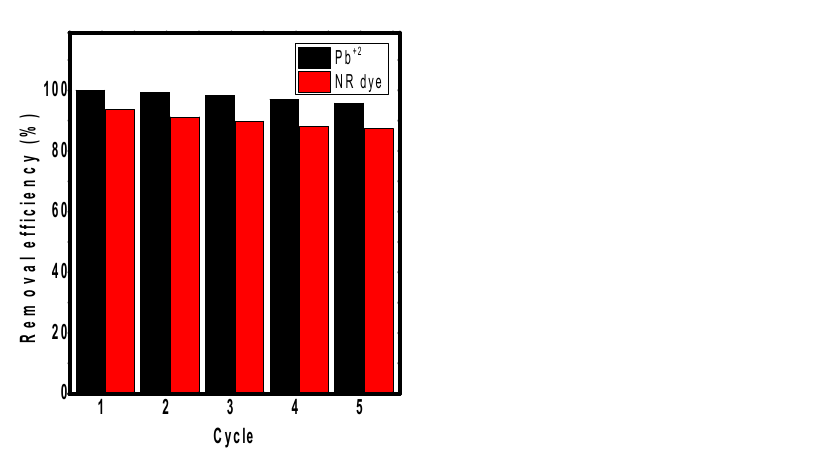
Figure 9. Regeneration of MnFe 2 O 4 /GO nanocomposite for Pb 2+ and NR dye removal up to five cycles.